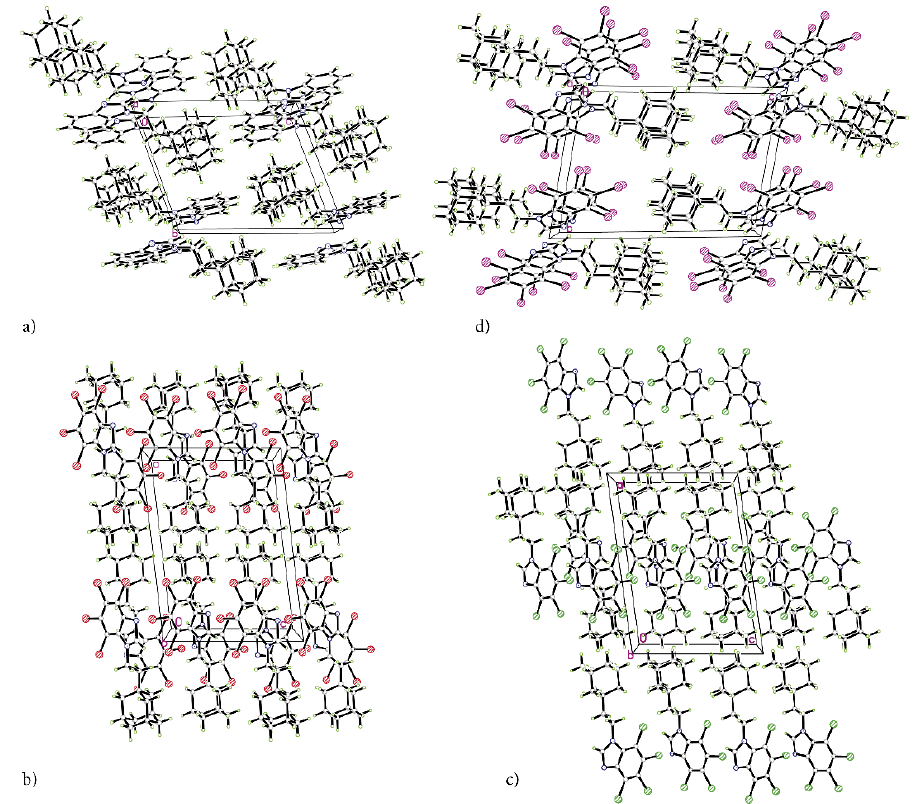
Figure 2. The packing of the crystal structures of adamantylated 4,5,6,7-tetrahalogeno-1 H -benzim- Figure idazoles. ( a ) AB, ( b ) tClAB, ( c ) tBrAB and ( d ) tIAB.